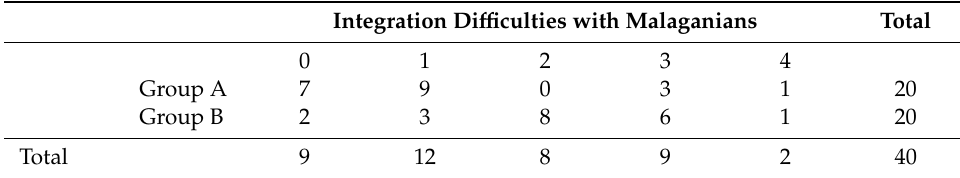
Table 7. Integration di ffi culties with Malaganians